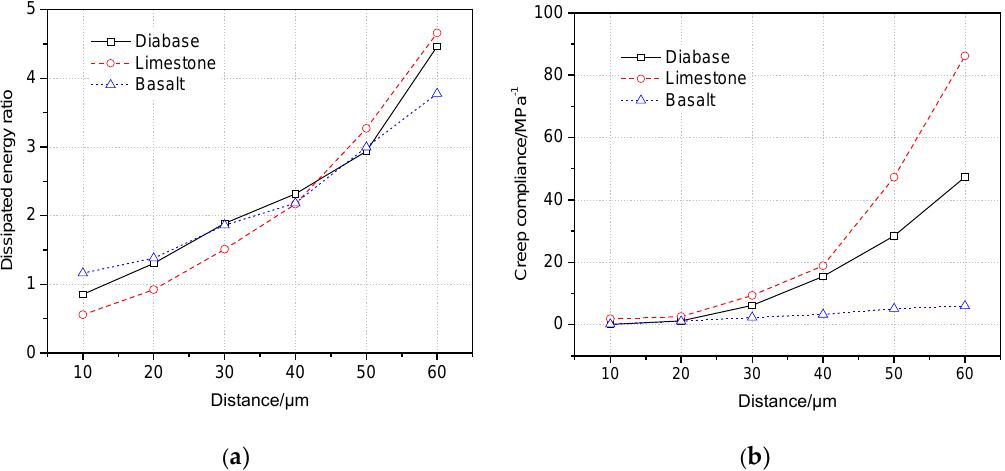
Figure13. Dissipatedenergyratioandcreepcompliance. ( a )Dissipatedenergyratio. ( b Figure 13. Dissipated energy ratio and creep compliance. ( a ) Dissipated energy ratio. ( b ) Creep compliance.